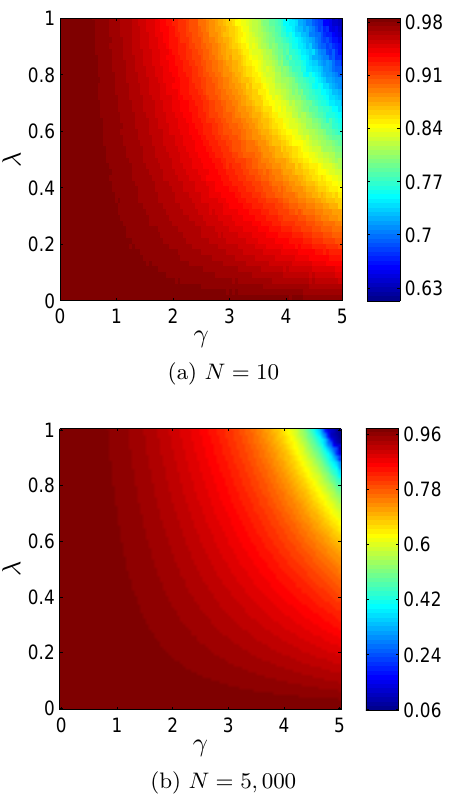
Figure 4: Polarization as a function of the relaxation rate α and the jump amplitude γ for (a) N = 10 , (b) N = 5 , 000 , where K = 2 , η = 0 . 1 , and λ = 1